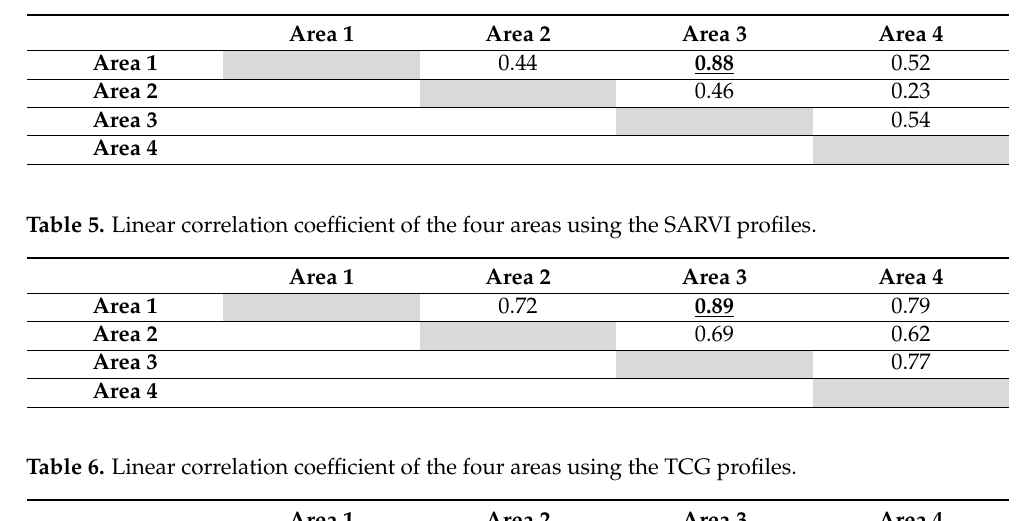
Table 4. Linear correlation coefficient of the four areas using the SAVI profiles.